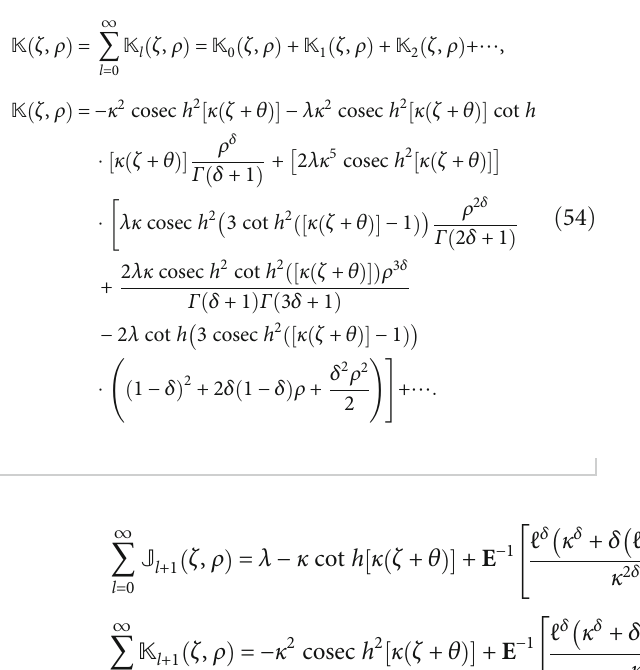
Figure 5: Graphical view of the exact and analytical solution for K ð ζ , ρ Þ at δ = 1 of system 1